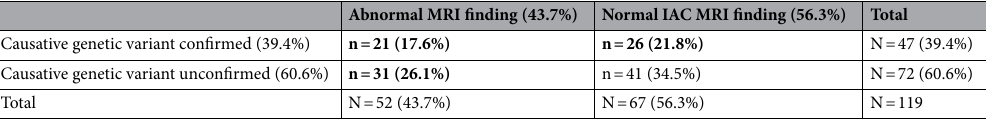
Table 1. Distribution of the pediatric severe-to-profound SNHL subjects, categorized by IAC-MRI findings and Molecular Genetic testing results. 78 subjects (66.5%) (bold) are etiologically diagnosed either by MRI or molecular genetic